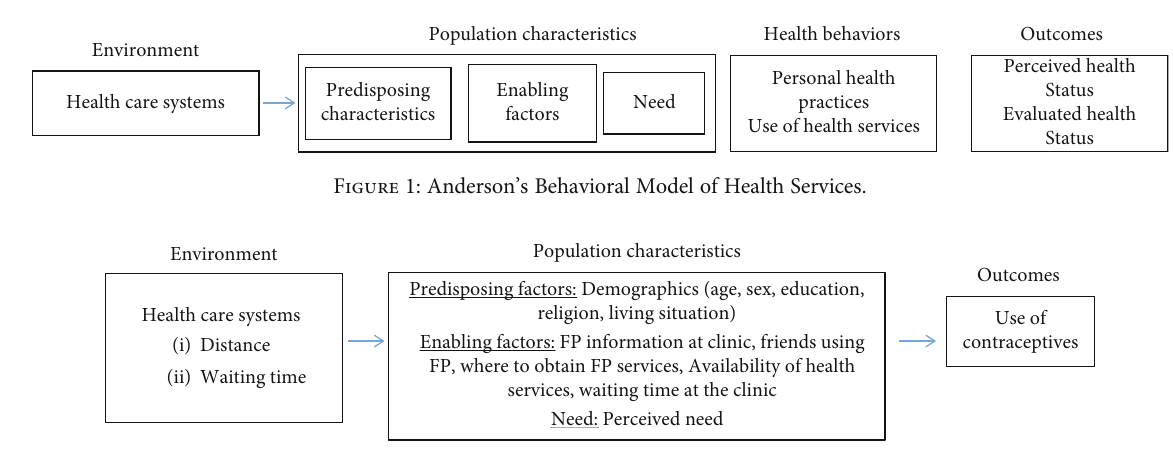
Figure 2: Independent variables and outcome variables mapped on to the theoretical framework: Andersen ’ s Behavioral Model of Health Service Use. FP =family